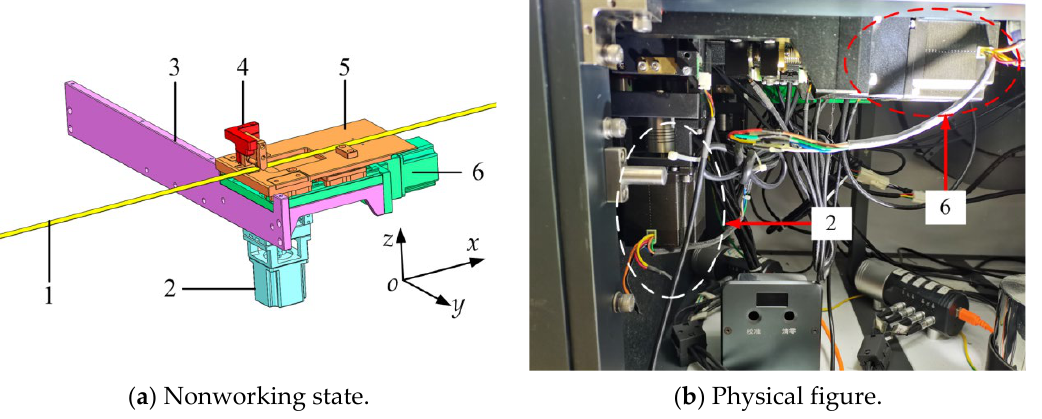
Figure 5. Force measuring device: 1. Steel tape; 2. stepping motor A for pressing mechanism; 3. fixed part; 4. pressing block; 5. slide block; 6. stepping motor B for tensioning mechanism.